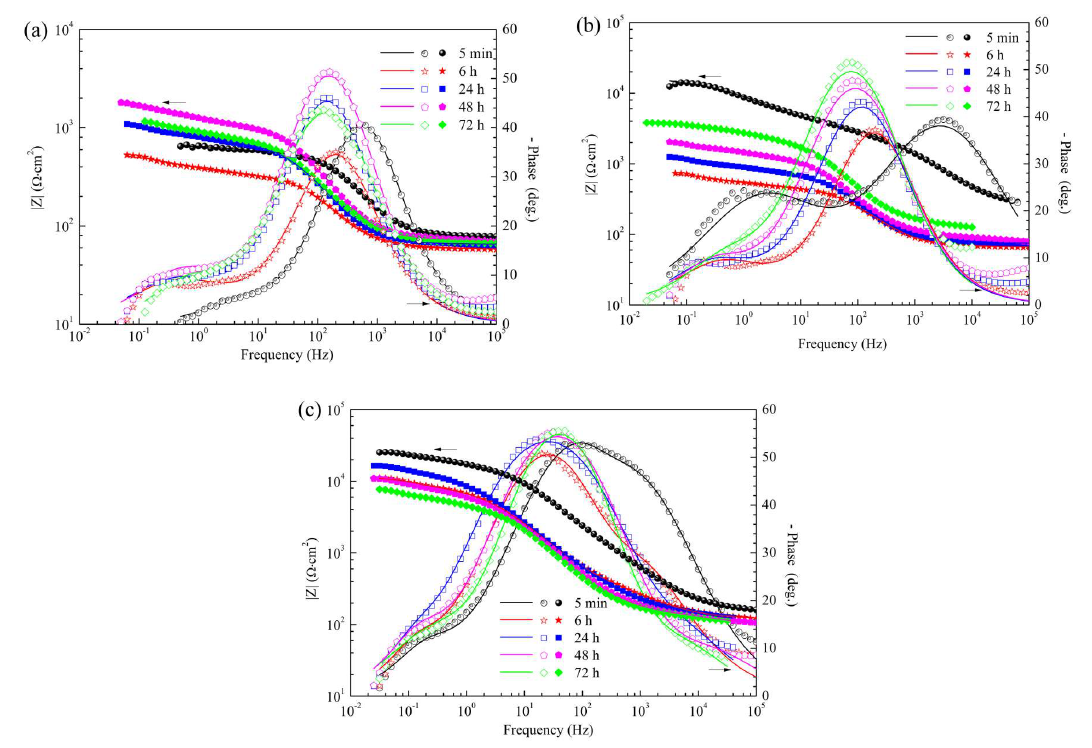
Figure 8. Bode plot of the pre-treated samples in SBF at 37 ± 0.5 ◦ C: ( a ) HT sample; ( b ) AT sample; ( c ) PEO sample. Symbols represent experimental data and solid lines are fitted